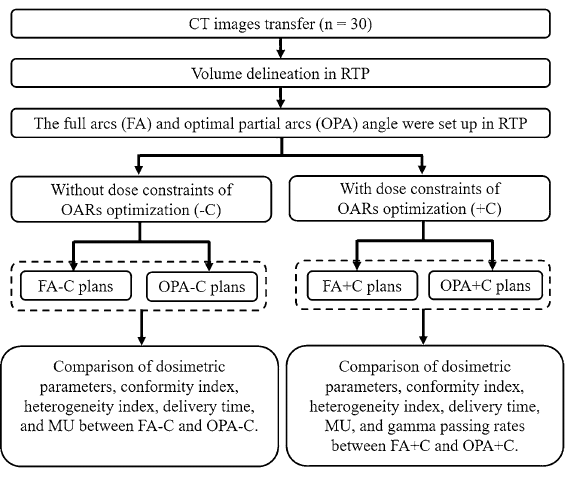
Figure 1. Flowchart of study